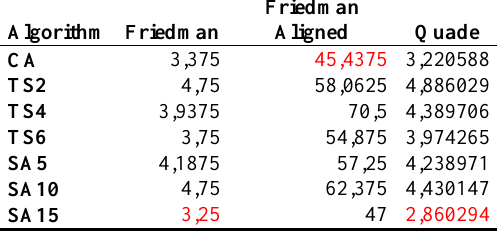
Table 8: Result for the junction of D-10 and D-30 Algorithm